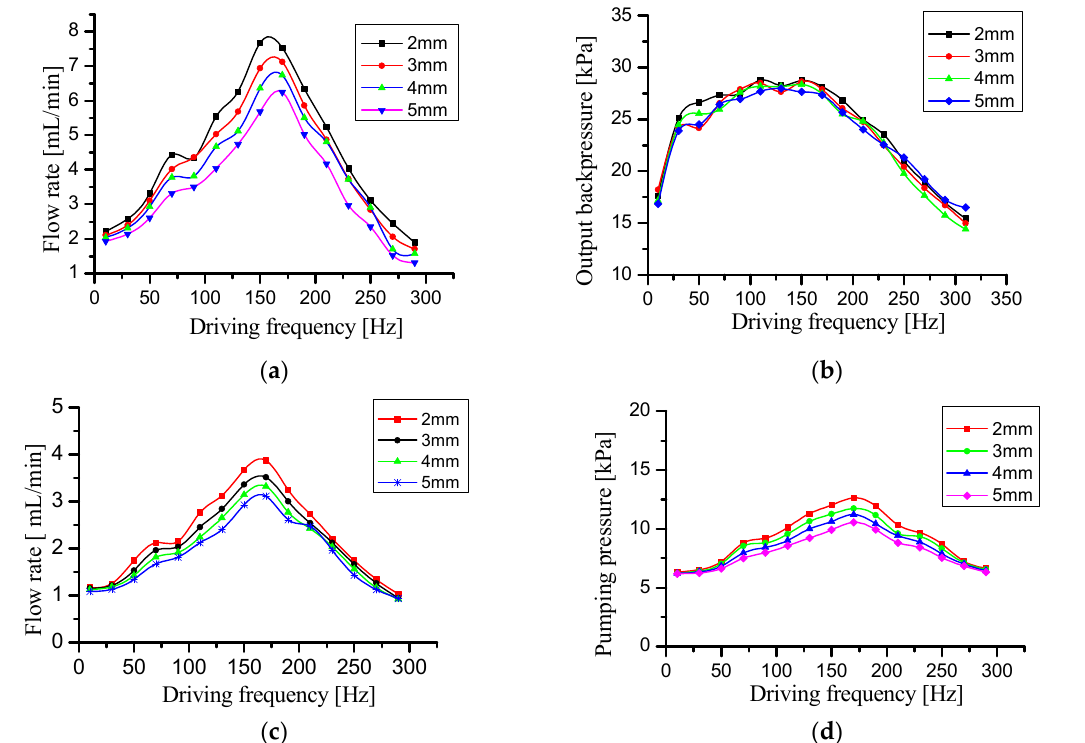
Figure 16. Performance comparison test curves of the four prototypes with elastic cavity heights of 2 mm, 3 mm, 4 mm and 5 mm. ( a ) Flow rate—driving frequency curves with needle valve fully open, ( b ) output backpressure—driving frequency curves with needle valve fully closed, ( c ) flow rate—driving frequency curves with 50% needle valve opening, and ( d ) output backpressure—driving frequency curves with 50% needle valve opening.